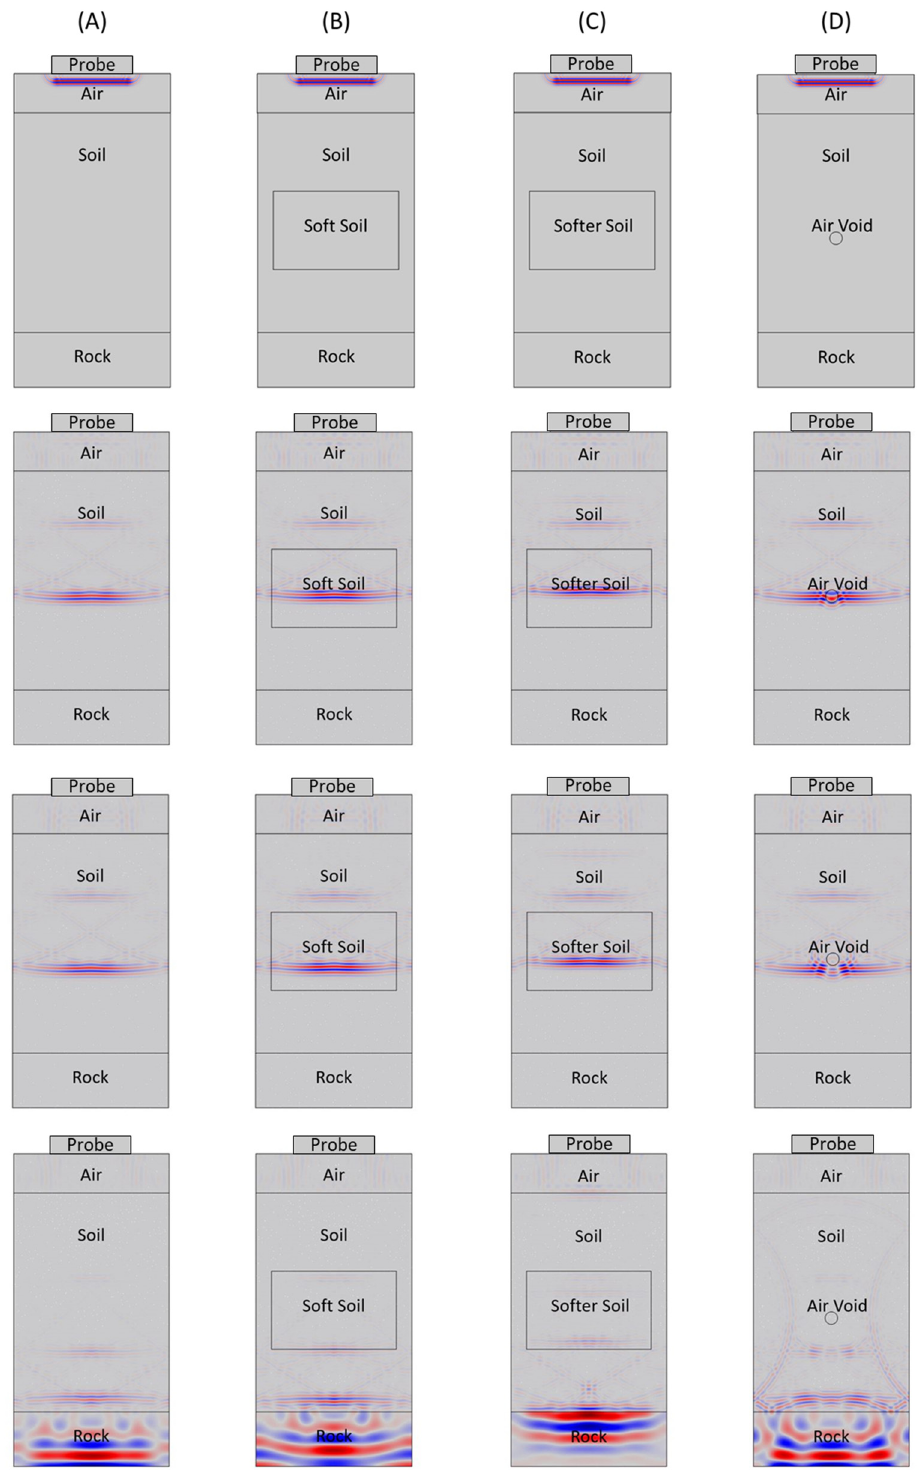
Figure 2. Sound wave propagation through air, soil and rocky layers in four different cases. The red and blue color scale indicated the positive and negative amplitude of the sound wave pressure. Case ( A ): healthy soil. Case ( B ): healthy soil with 5% properties reduction for the soft soil region. Case ( C ): healthy soil with a softer soil region with 5% lower values compared to the soft soil in ( B ). ( D ): healthy soil with a small internal air void. The size of the air void is smaller than the sound wavelength.